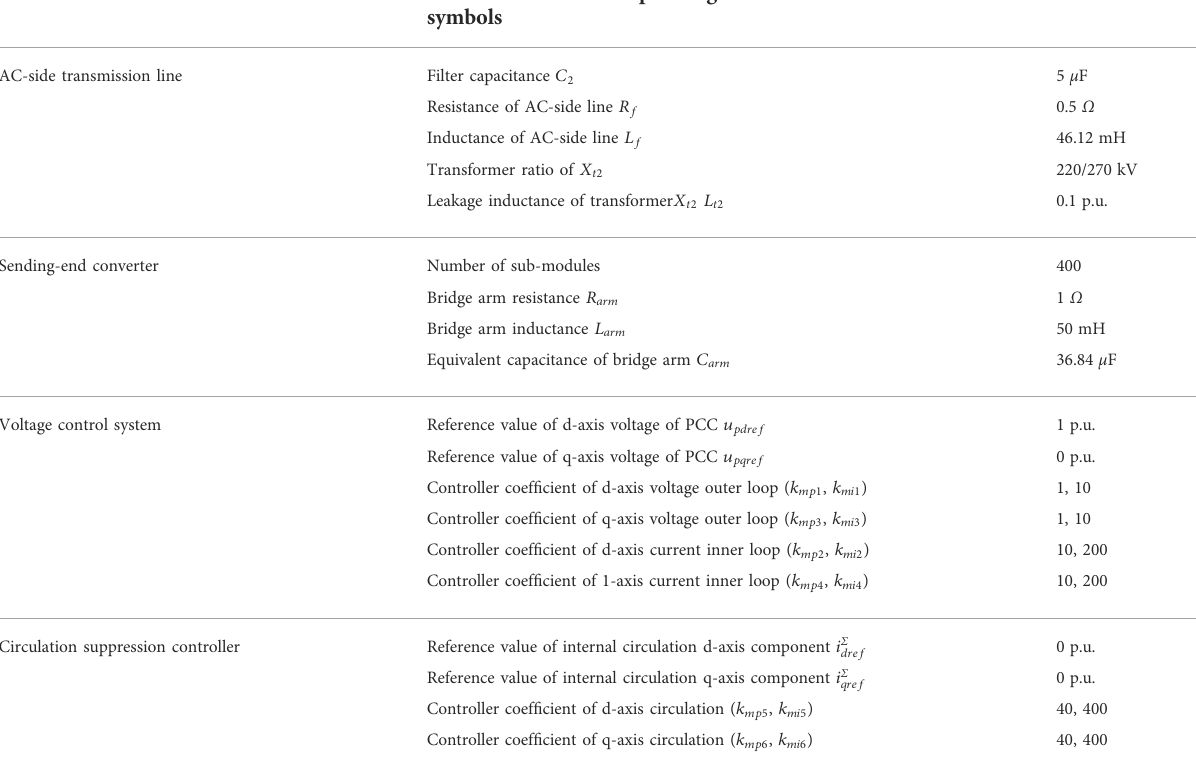
TABLE 4 MMC system parameters.